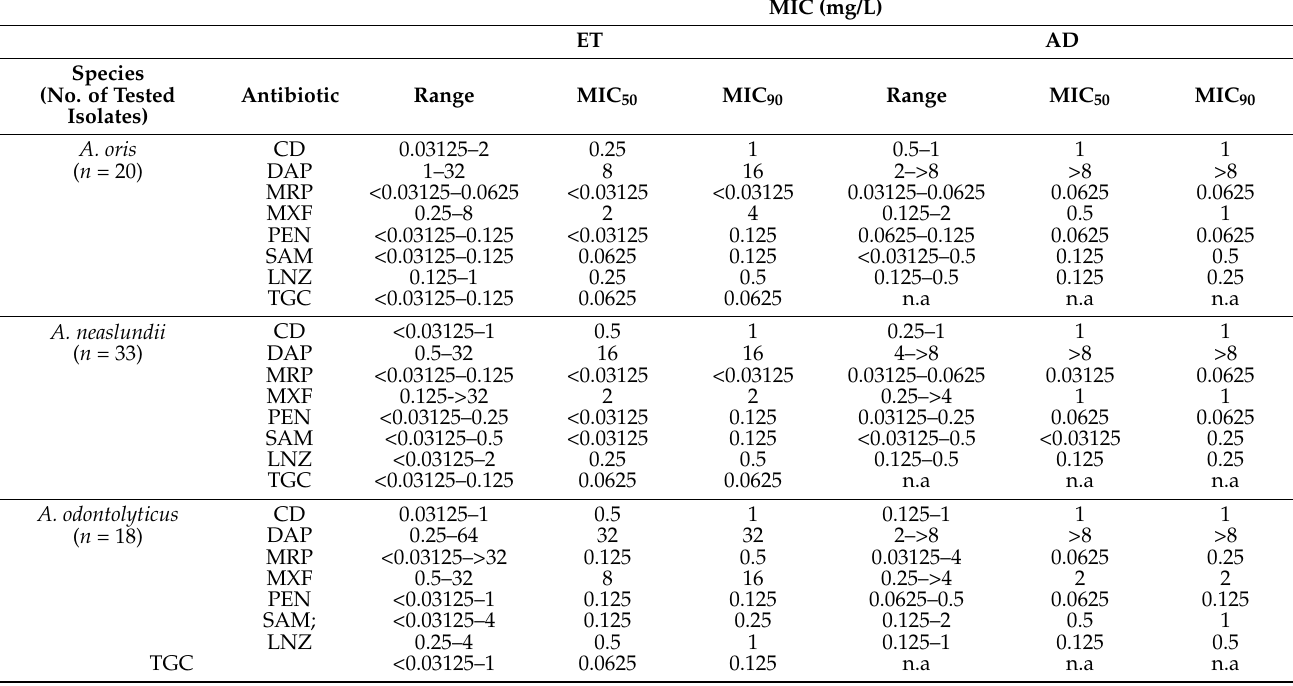
Table 4. Comparison of agar dilution MICs and E-Test MICs by antimicrobial agent tested against the three most common Actinomyces species in our